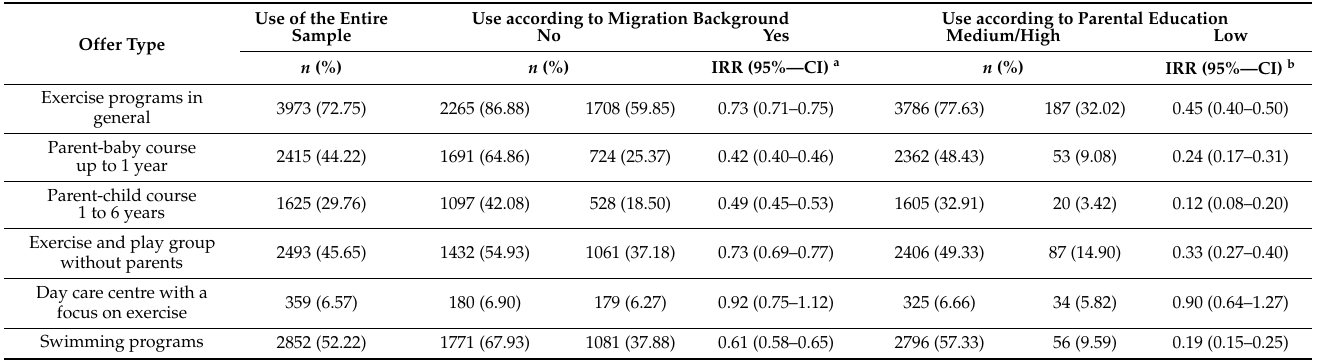
Table 2. Use of Exercise Programs for the total Sample and according to Social Situation.